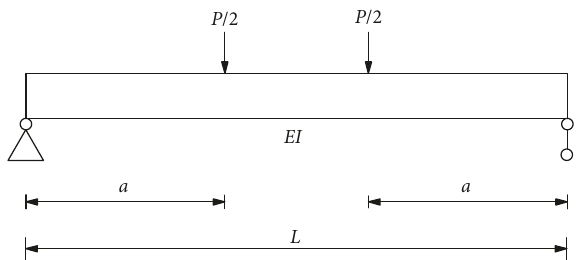
Figure 1: Mechanical diagram of a simply supported girder under symmetrical loading.